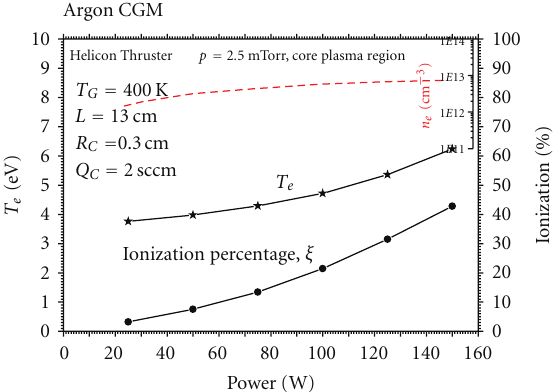
Figure 19: Calculated n e , T e , and ionization percentage versus absorbed power in the core plasma region.